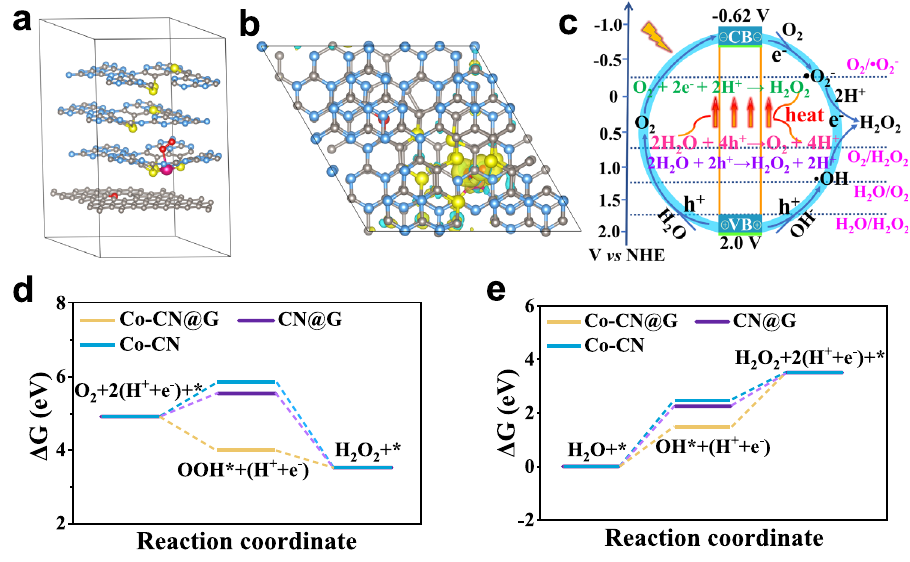
Fig. 5 | DFT calculations. a Cross view for O 2 adsorption con fi guration over Co – CN@G. b Top view of the charge difference density of O 2 adsorption on Co – CN@G. Yellow and cyan iso-surface represents electron accumulation and electron depletion, respectively. Blue, gray, yellow, rose, and the red color